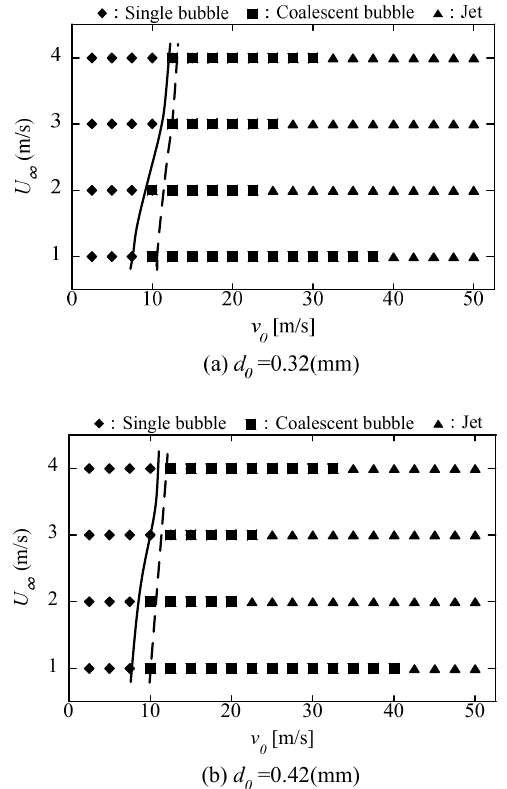
Fig. 6 Classification of the flow patterns of separating